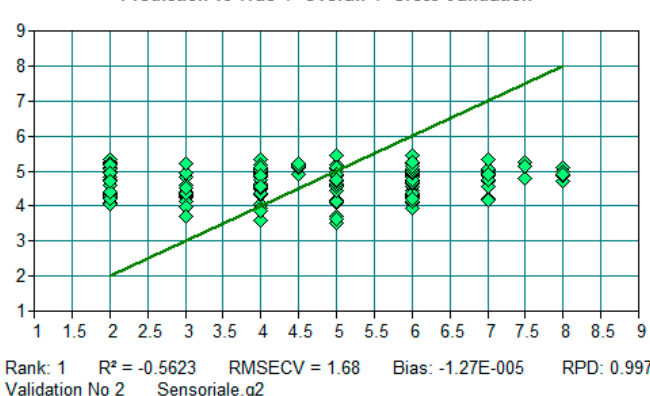
Figure 2. Output of OPUS/QUANT software: Validation curve of “preference” parameter from sensory analysis.